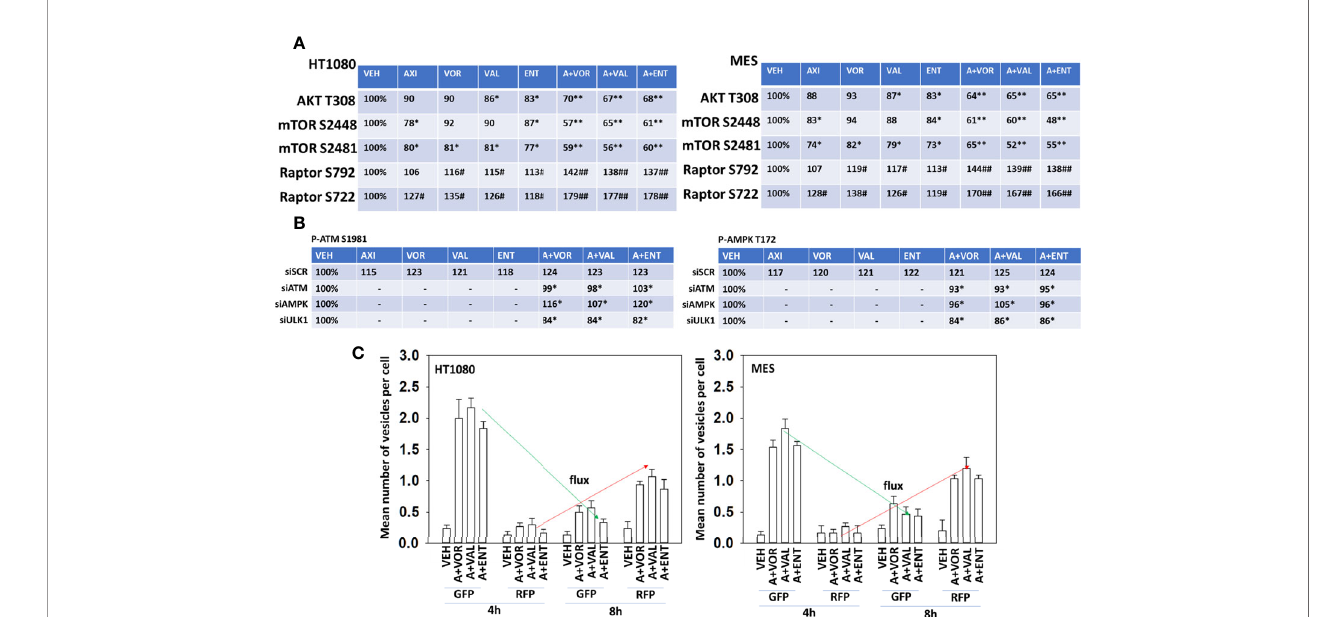
FIGURE 2 | Axitinib combined with HDAC inhibitors inactivates AKT, mTORC1, mTOR2 and Raptor. (A) Human sarcoma cells were treated with vehicle control, axitinib (50 nM), entinostat (50 nM), vorinostat (500 nM), sodium valproate (250 m M) alone or in combination as indicated in the graphical panels for 6h. Cells were fi xed in place and in-cell immunoblotting performed to determine the total protein levels of AKT, mTOR and Raptor, and the phosphorylation of AKT T308, mTOR S2448, mTOR S2481, Raptor S792 and Raptor S722. The percentage phosphorylation is stated for each site corrected for total protein loading with vehicle control de fi ned as 100% (n = 3 +/-SD). *p < 0.05 less than vehicle control; **p < 0.05 less than HDAC inhibitor alone; # p < 0.05 greater than vehicle control; ## p < 0.05 greater than HDAC inhibitor alone. (B) HT1080 cells were transfected with a scrambled control siRNA (siSCR) or with validated siRNA molecules to knock down the expression of either ATM or AMPK a . Twenty-four h after transfection, cells were treated with vehicle control, axitinib (50 nM), entinostat (50 nM), vorinostat (500 nM), sodium valproate (250 m M) alone or in combination as indicated in the graphical panels for 6h. Cells were fi xed in place and in-cell immunoblotting performed to determine the total protein levels of ATM and AMPK a , and the phosphorylation of ATM S1981 and AMPK a T172 determined. The percentage phosphorylation is stated for each site corrected for total protein loading with vehicle control of each transfection being de fi ned as 100% (n = 3 +/-SD). # p < 0.05 greater than vehicle control value; *p < 0.05 less than corresponding value in siSCR cells. (C) Sarcoma cells were transfected with a plasmid to express LC3-GFP-RFP. Twenty-four h after transfection, cells were treated with vehicle control, [axitinib (50 nM) + entinostat (50 nM)], [axitinib (50 nM) + vorinostat (500 nM)], [axitinib (50 nM) + sodium valproate (250 m M)] in combination as indicated in the graphical panels for 4h and 8h. The mean number of intense green and red punctae from a minimum of 40 cells are de fi ned and plotted (n = 3